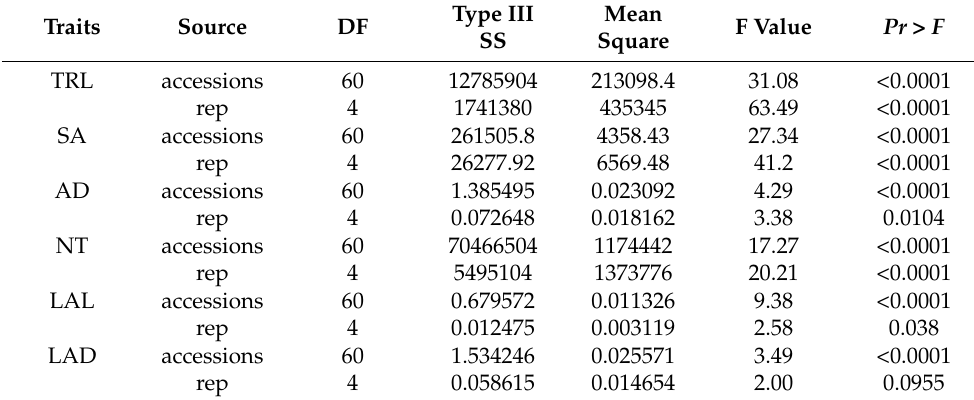
Table 2. Analysis of variance of six root morphological traits. Traits